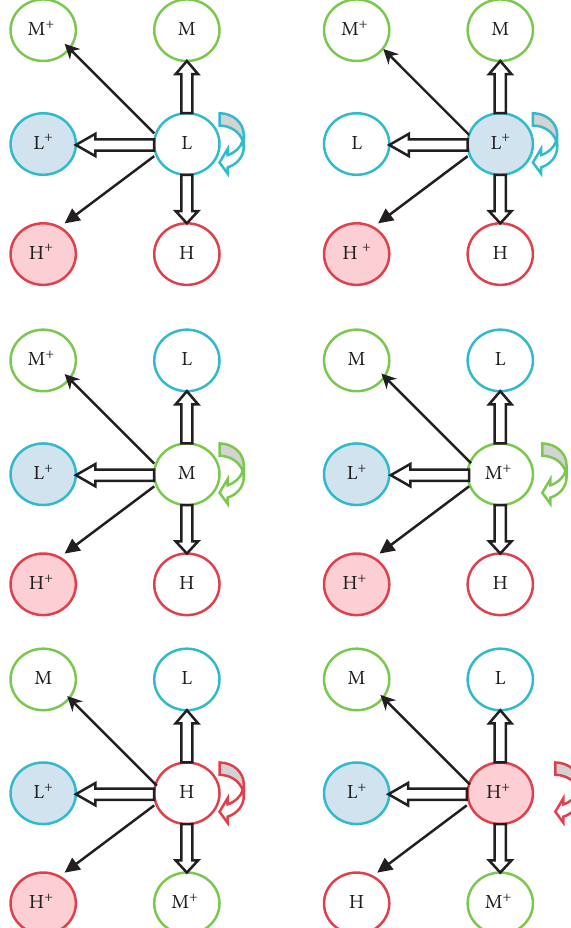
Figure 7: Markov model of the solar energy for the states ( L ) L +, ( M ) M +, and H